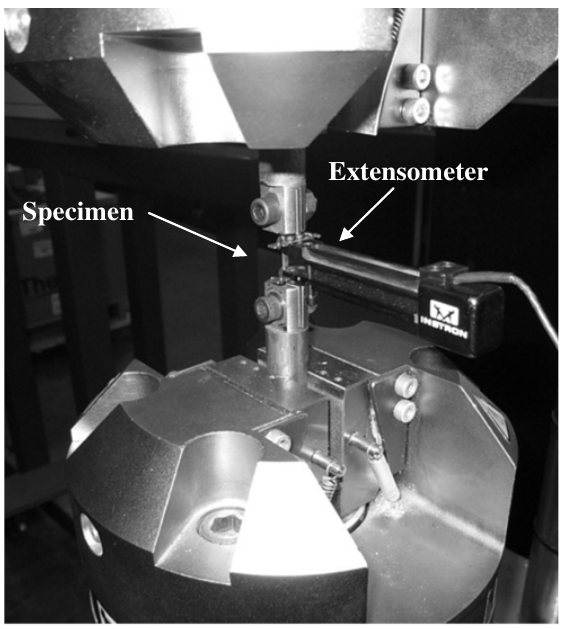
Fig. 3. Quasi-static experimental